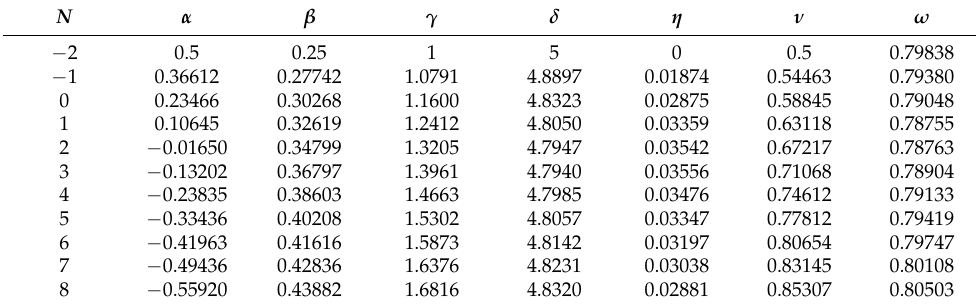
Table 4. Critical exponents for the O ( N ) -symmetric ϕ 4 field theory obtained by the summation of ε expansions using self-similar factor